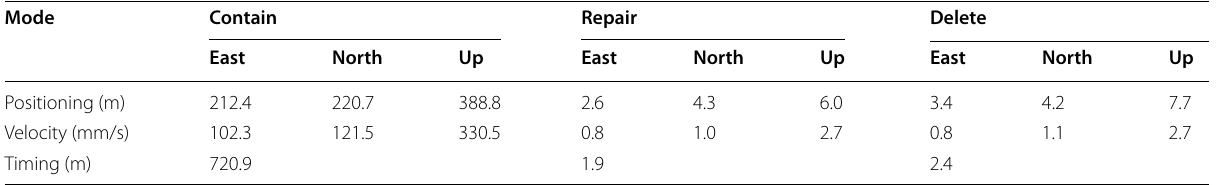
Table 3 The average STDs of the positioning, velocity, and timing biases for the different approaches with five orbital maneuvers (“Contain”, “Repair”, “Delete” means containing, repairing and deleting maneuver satellite,